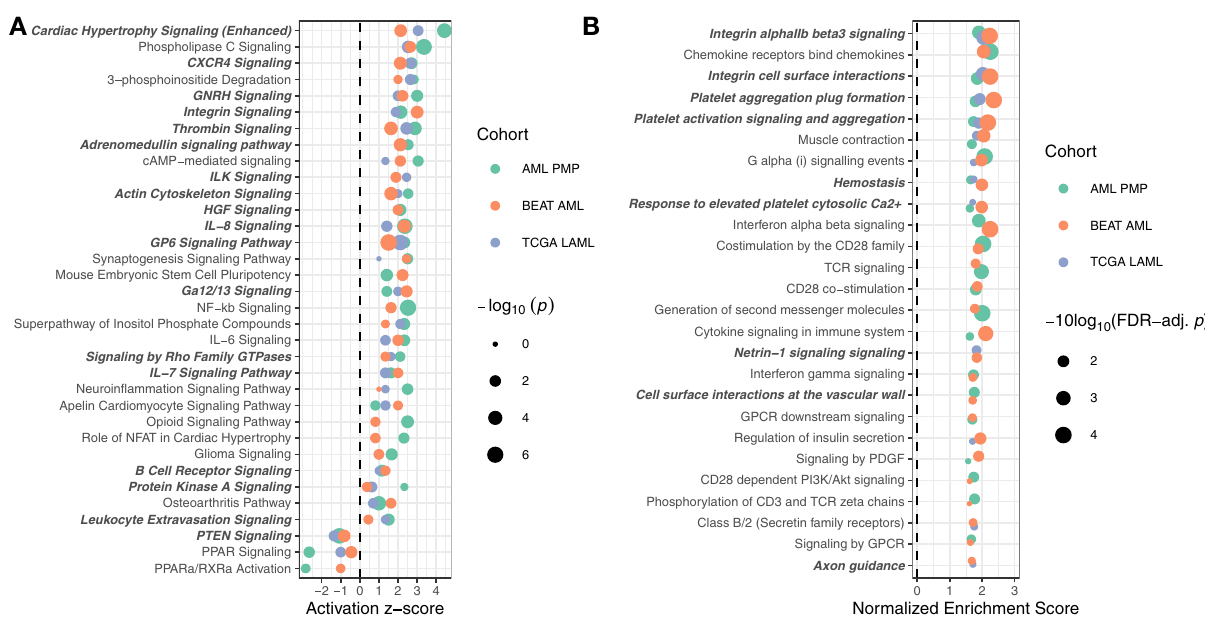
Fig. 6 Pathway enrichment analysis. A Pathway enrichment analysis of IPA canonical pathways overrepresented in differentially expressed genes across all three cohorts. Pathways are ranked by mean activation z -score, with point size scaled by Fisher ’ s exact test p values. B Geneset enrichment analysis (GSEA) against the Reactome pathway database. Pathways are ranked by the number of cohorts the pathway was enriched in, then by the mean FDR- adjusted p value across cohorts. GSEA p values are derived from permutation testing, and corrected for multiple testing using the FDR method. In both panels, gene sets containing PTK2 and/or ITGB3 are highlighted in bold and